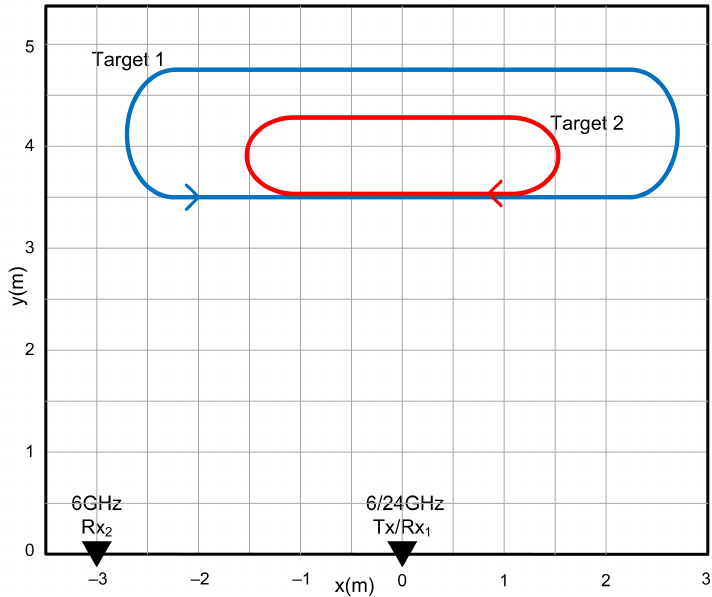
Figure 9. The radar and targets geometry for scenario